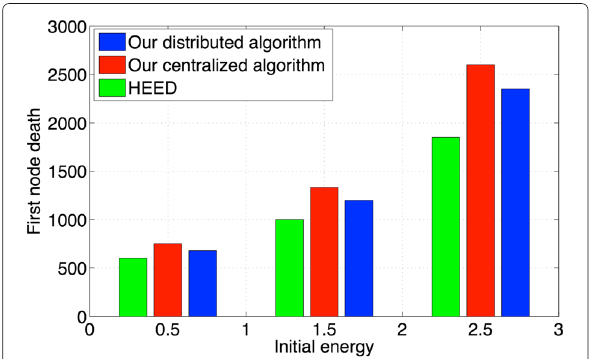
Fig. 5 Impact of the initial energy. When the initial energy of sensor nodes is increased from 0.5 to 1.5 and then up to 2.5, the advantage of our algorithms over HEED becomes more obvious in terms of prolonging the network